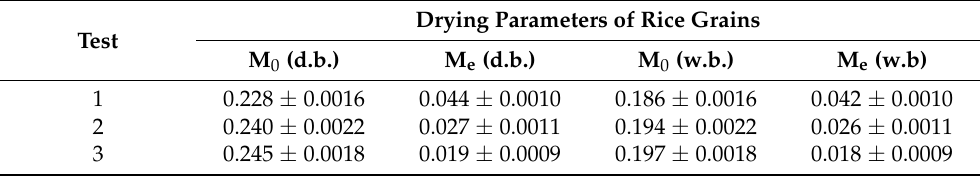
Table 2. Moisture content of the sample at the beginning and final of the drying